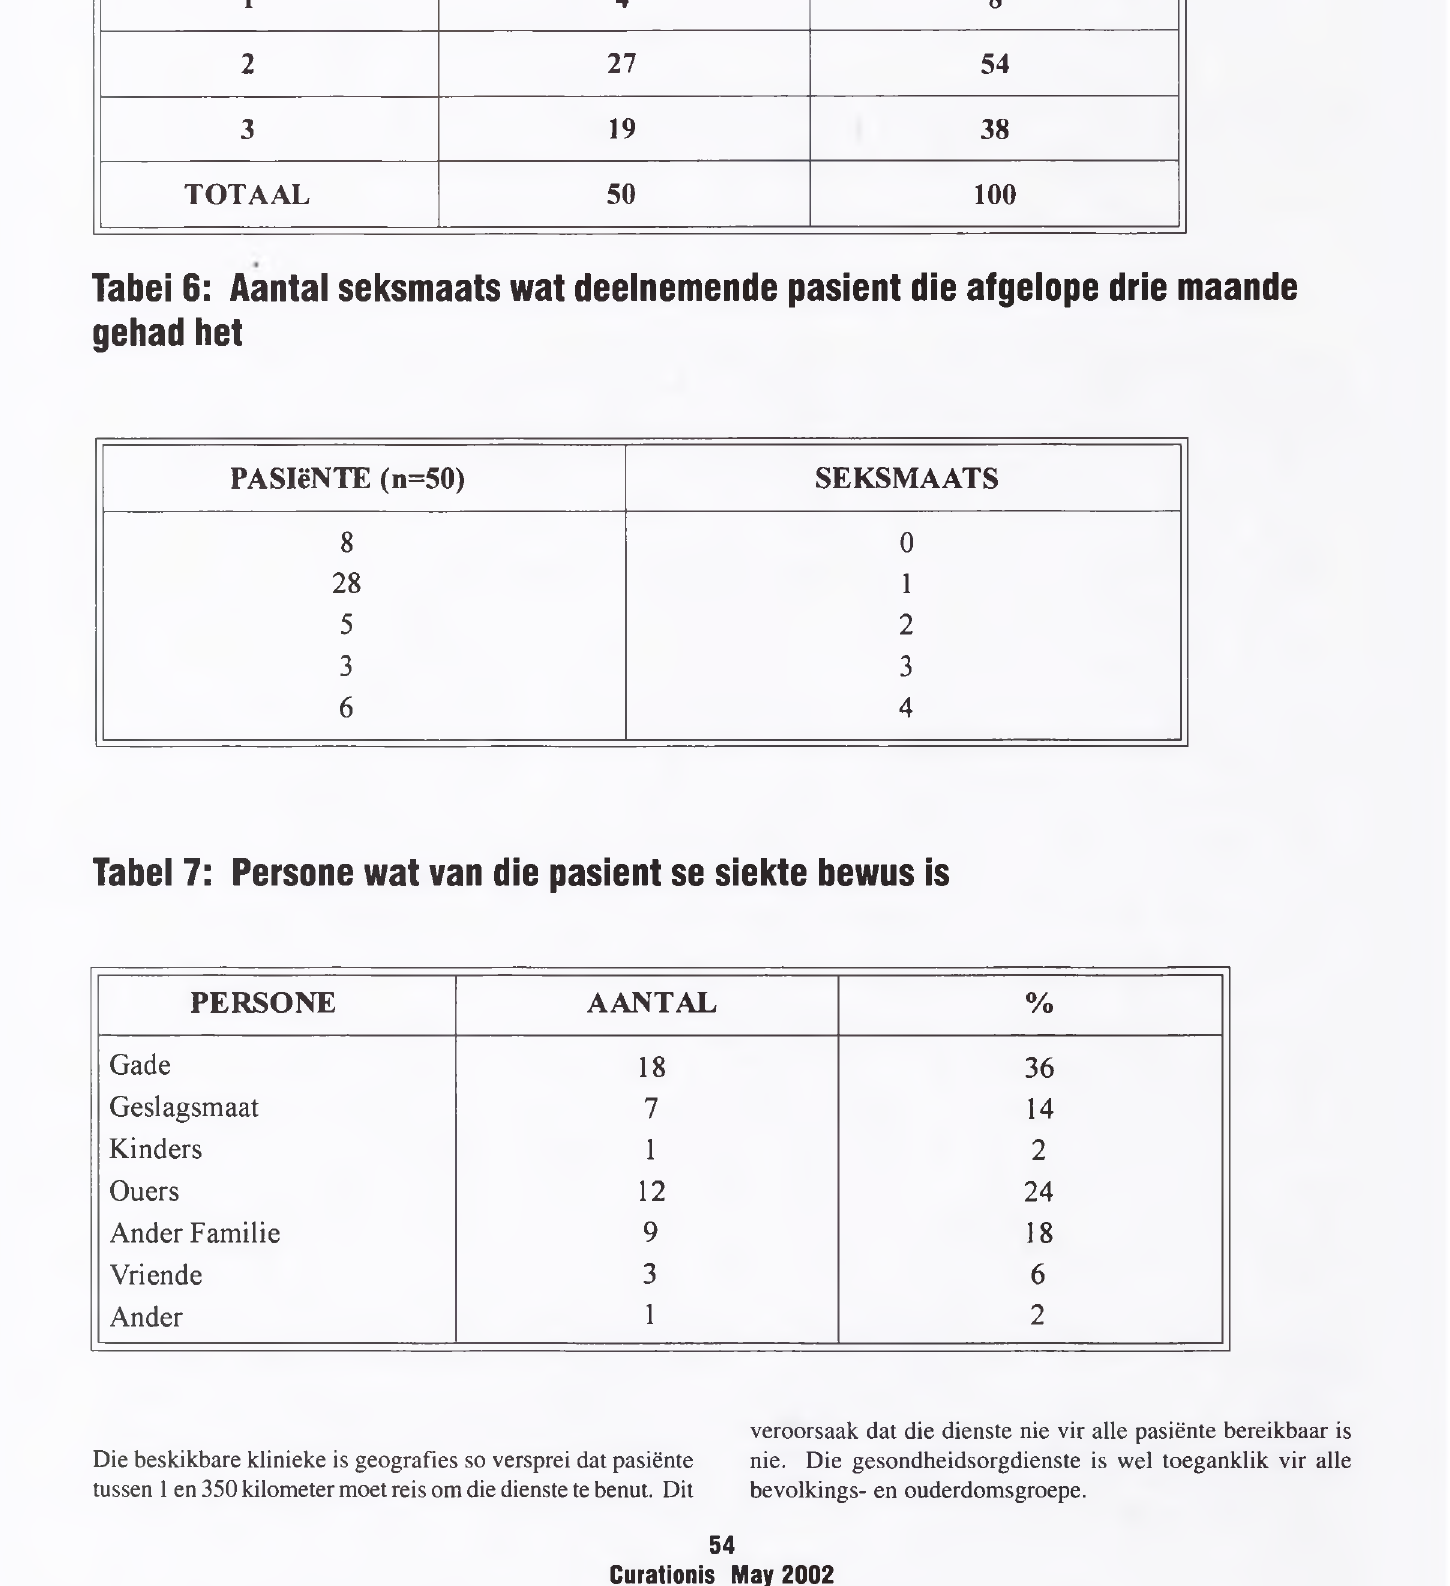
Tabei 6: Aantal seksmaats wat deelnemende pasient die afgelope drie maande gehad het